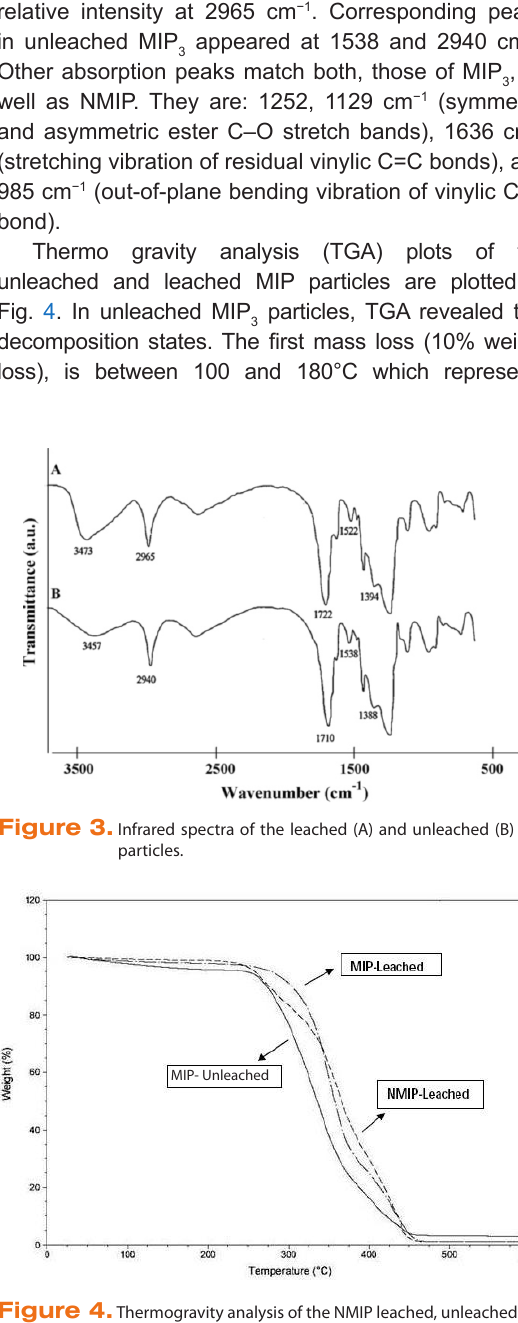
Figure 4. Thermogravity analysis of the NMIP leached, unleached and leached MIP particles.